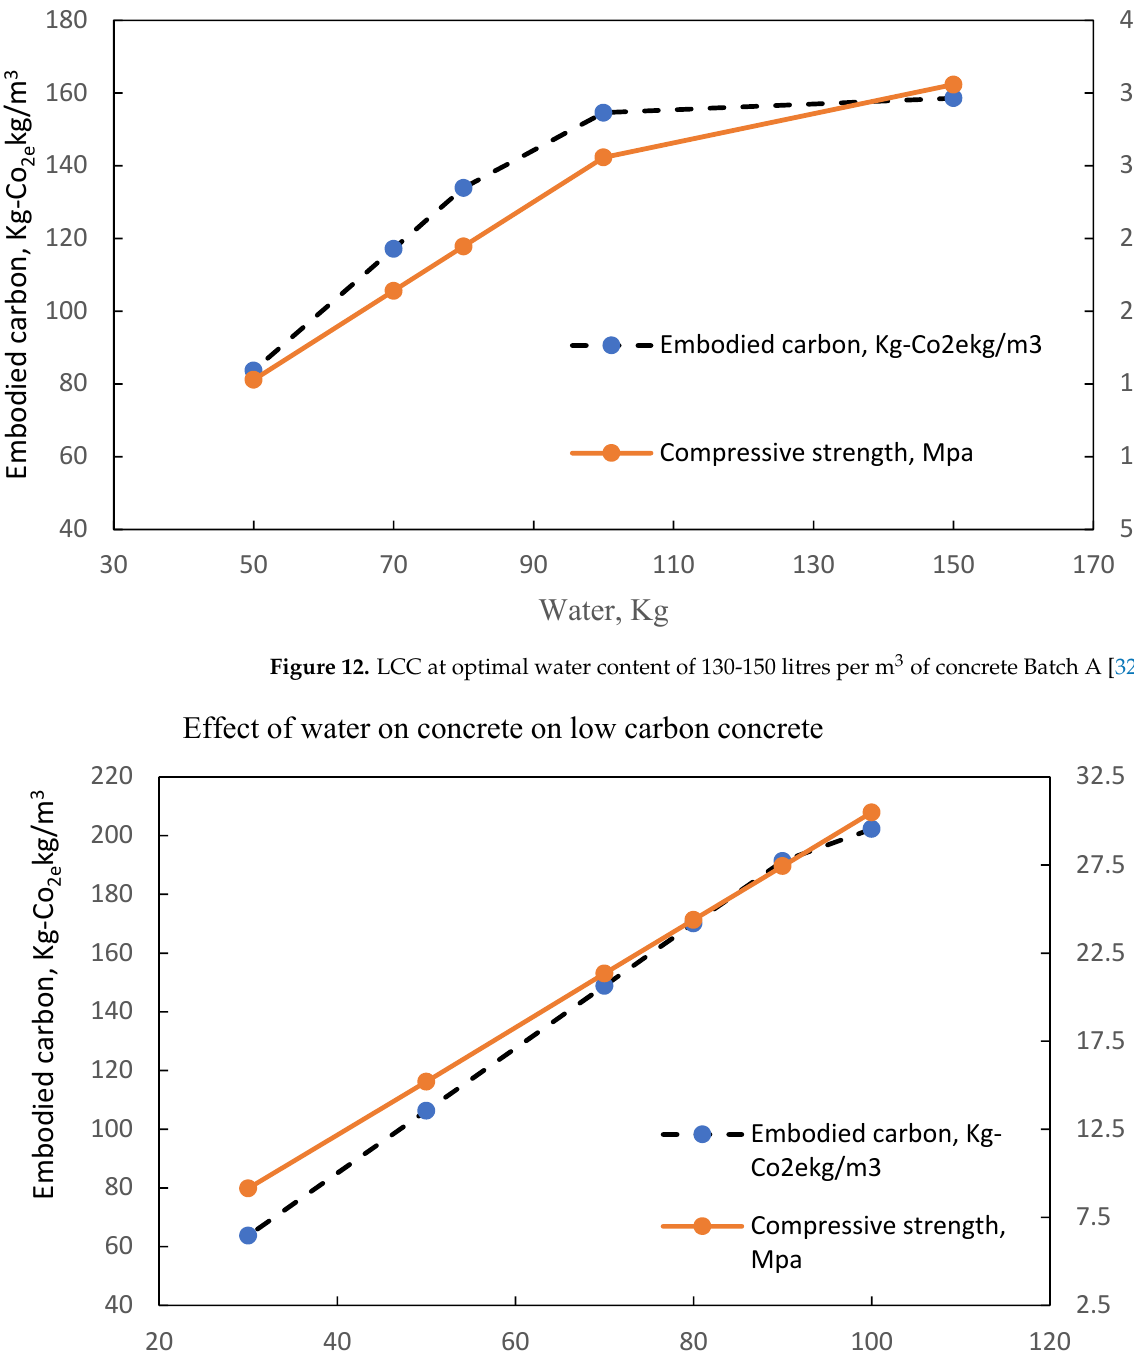
Figure 11. LCC at optimal water content of 80 litres per m 3 of concrete [22].